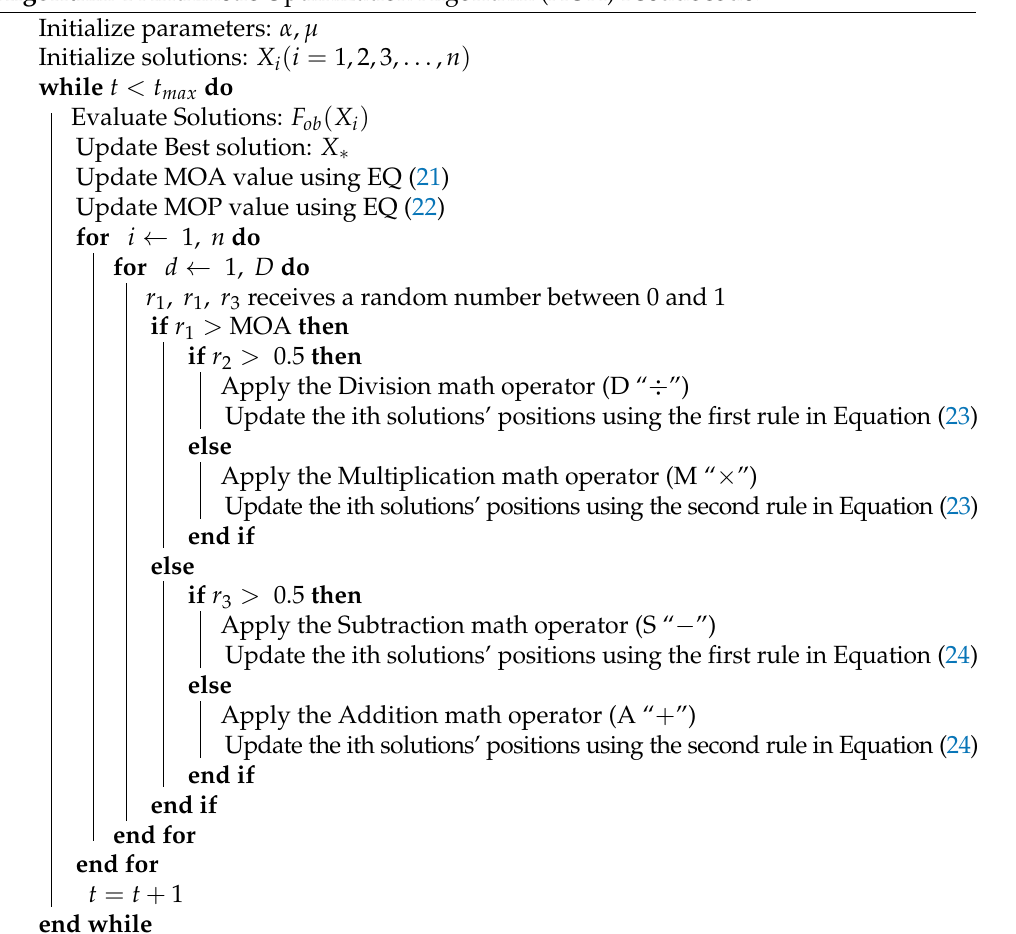
Algorithm 4 Arithmetic Optimization Algorithm (AOA)